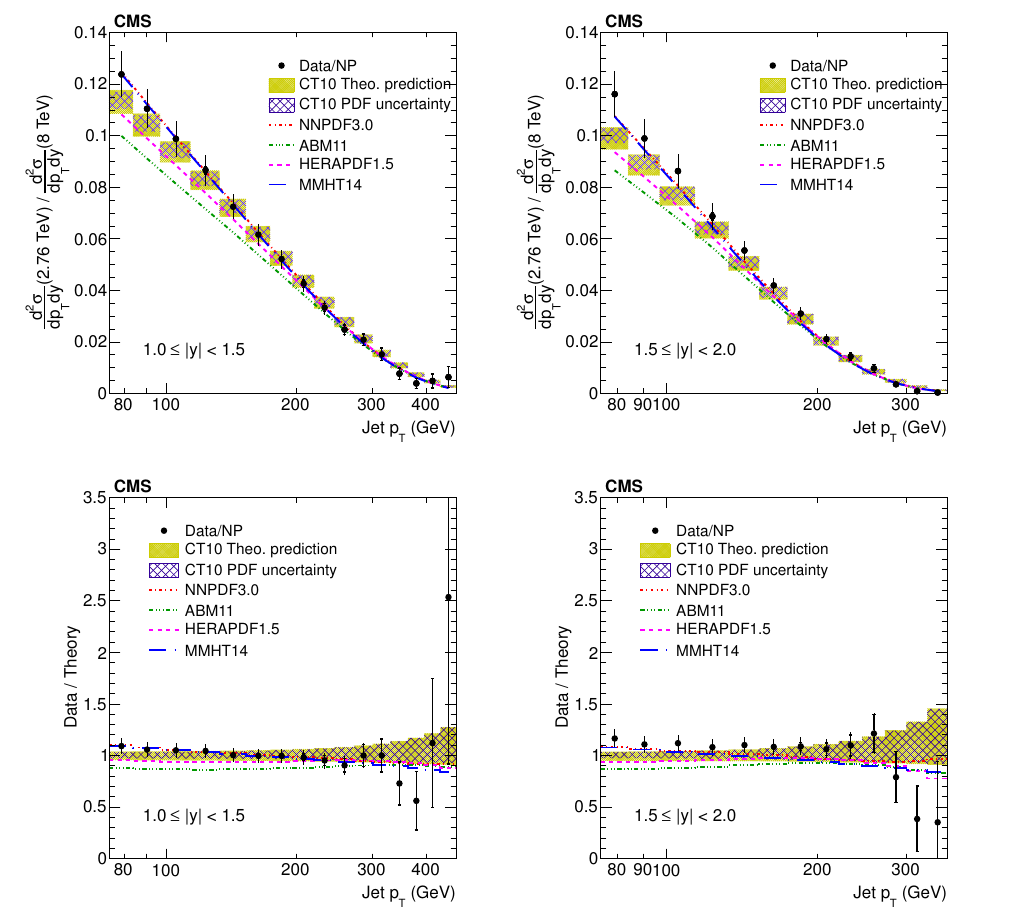
p s = 2.76 and 8 TeV shown